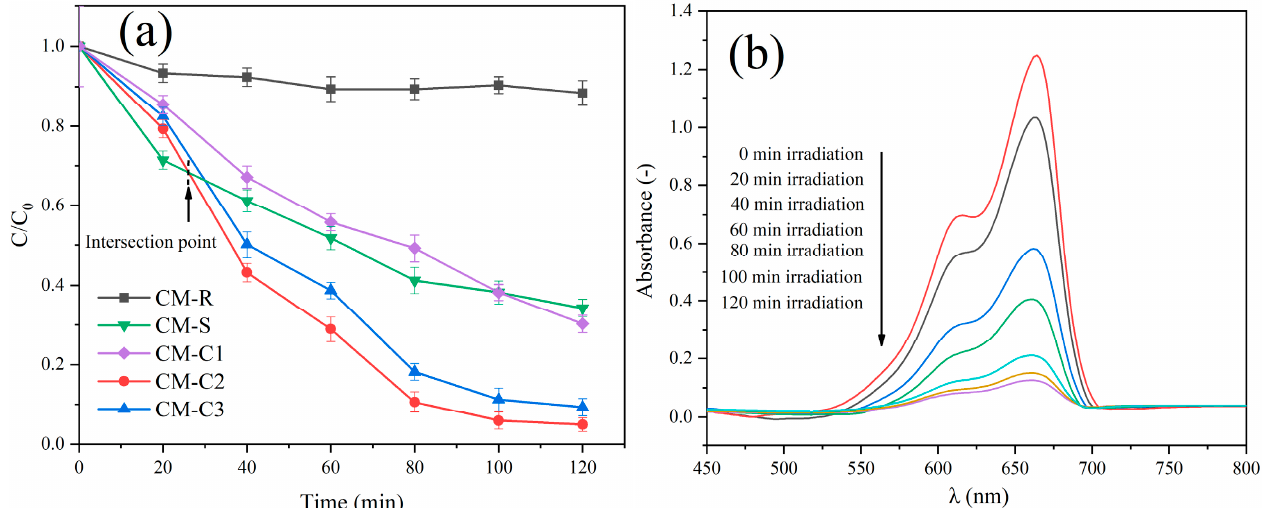
Figure 6. Photocatalytic measurements: ( a ) photocatalytic activity of mortar samples; ( b ) absorbance spectra of MB degradation with UV-visible irradiation time for CM-C2.